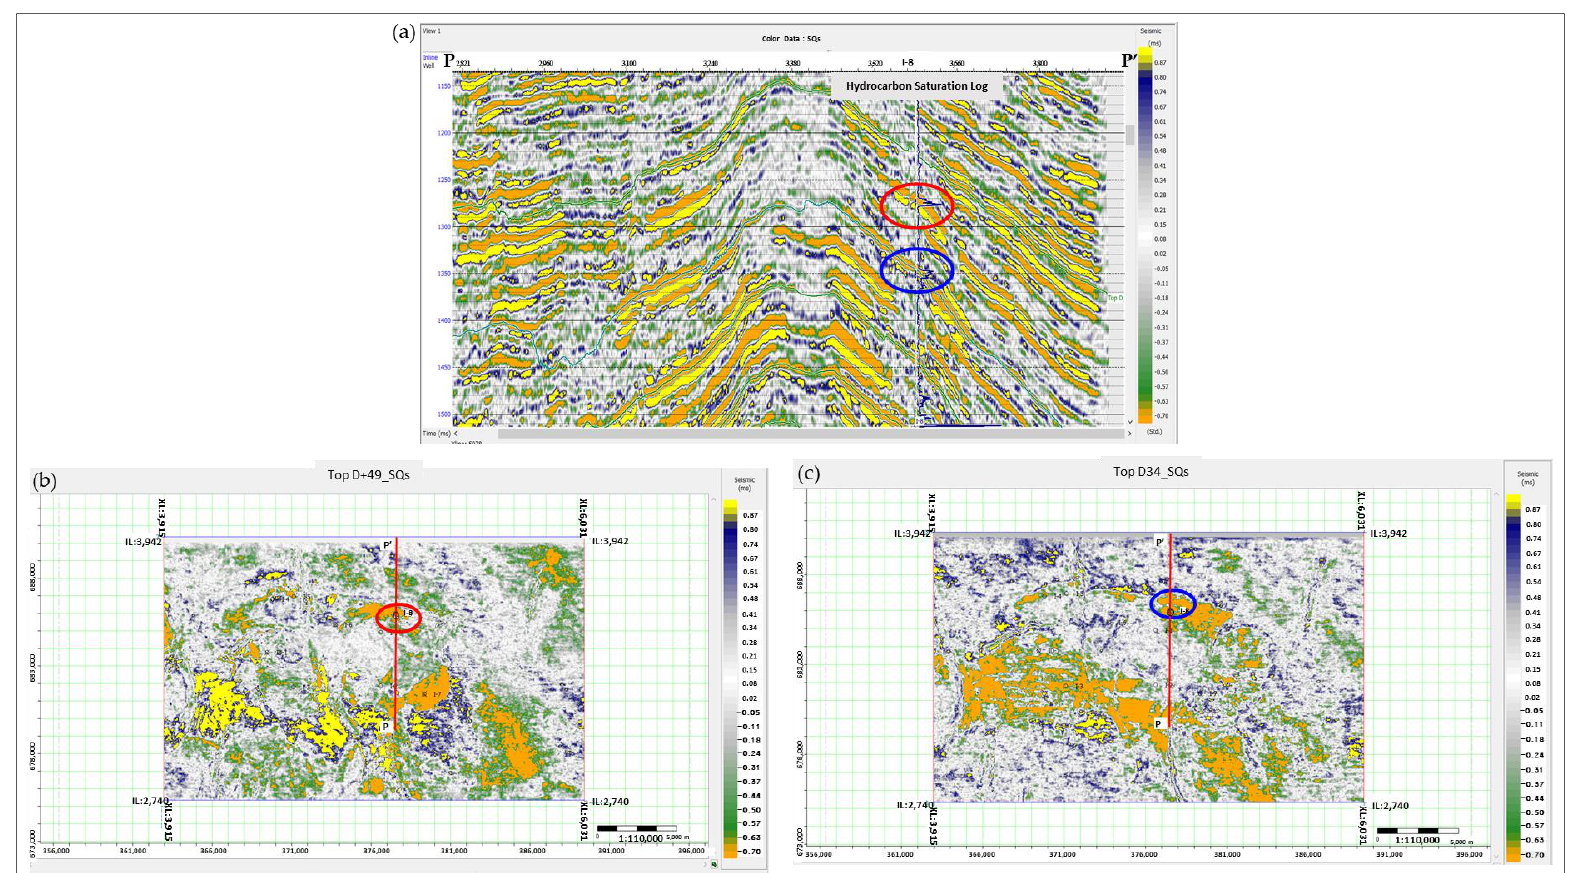
Figure 14. Application of scale of quality factor of S-wave (SQs) attribute to distinguish fluid distribution. ( a ) Seismic intersection which was penetrated by I-8 well log showed that the gas zone identified as an orange color. The red circle was top D + 49 while the blue circle was top D34/36. These circles illustrated the consistency result between SQs attribute application and hydrocarbon saturation log responses for the hydrocarbon prediction, ( b ) seismic attribute slice for Top D + 49 ms zone. The red circle was the gas sand area for top D + 49, which was penetrated by I-8 log, and ( c ) seismic attribute slice for the top D34/36 zone. The blue circle was the gas sand area for top D34/36, which was penetrated by the I-8 log.